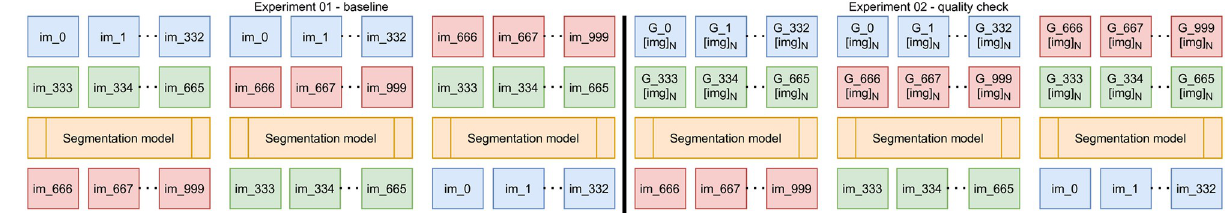
Fig 8. The experiment setup to analyze the quality of SinGAN output. Experiment 01—the baseline experiments performed only using the real data. Experiment 02—in this experiment, generated synthetic data is used to train segmentation models, and the real data is used to measure the performance